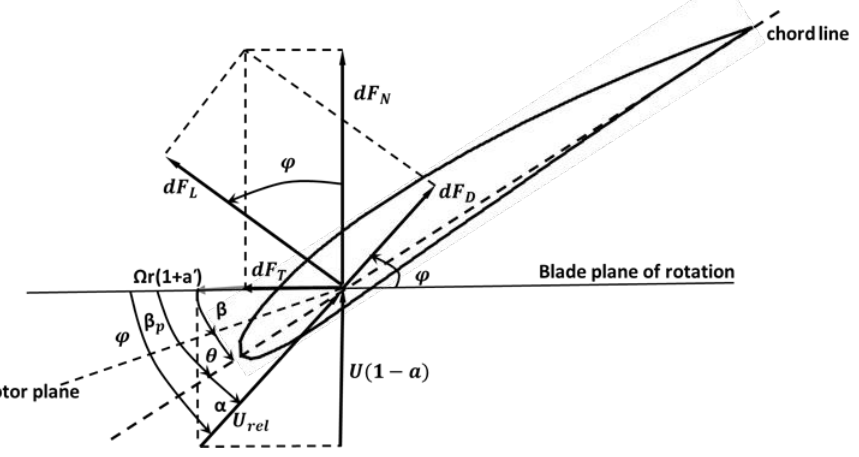
Figure 9. Forces and velocities acting on WT airfoil and their angles.